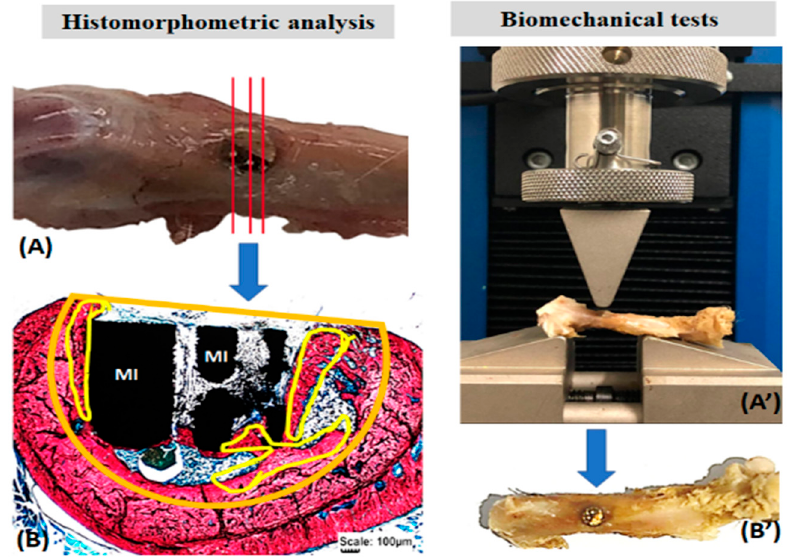
Figure 2. Histomorphometric analysis of the formed bone volume ( A , B ) and the biomechanical resistance of the surgical area in the femur of rats ( A’ , B’ ). Histological sections of the total surgical area ( A ) stained with Stevens blue to delimit the volume of the bone defect (orange) and the formed bone (yellow) ( B ). In biomechanics ( A’ ), the surgical area (arrows, ( B’ )) was subjected to a load by the rod of the EMIC 23-2S equipment ( A’ ). Metallic implant (MI).